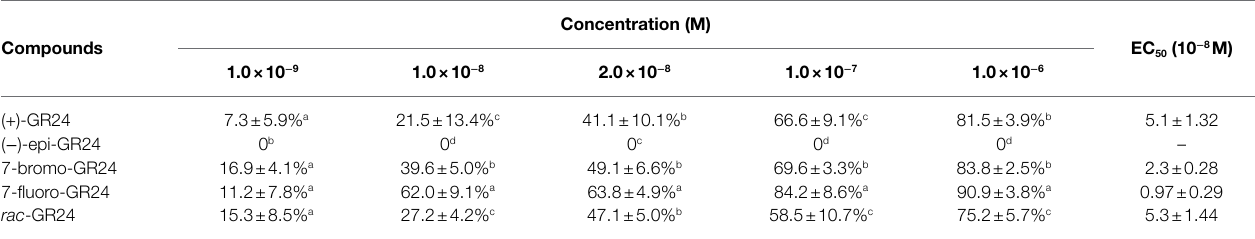
Different lowercase letters in the same column indicate significant differences between means, according to the least significant difference test (p < 0.05). Values represent means ± SD (n =